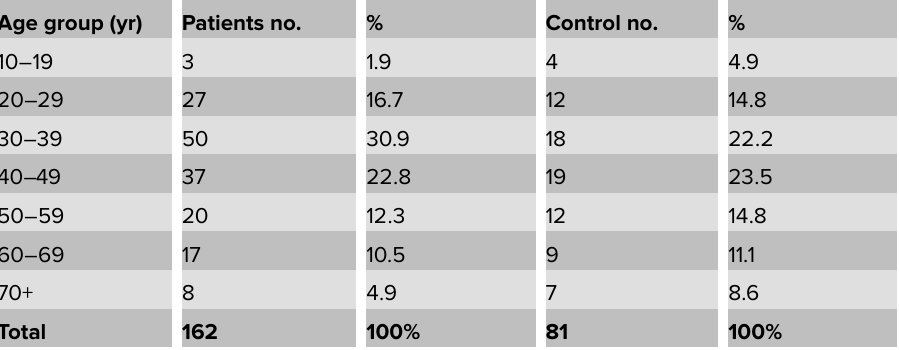
Table 1: The age distribution of cases and